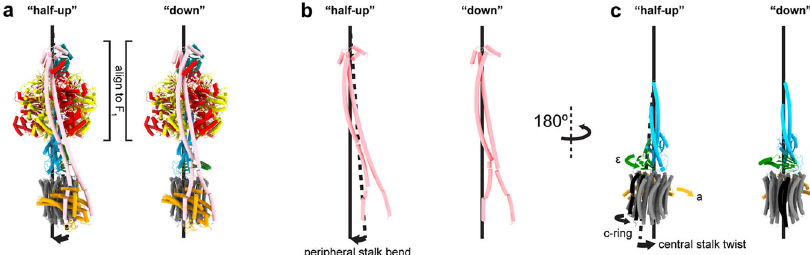
Fig. 5 Movements of the central and peripheral stalks. Side views showing the comparison of State 2 half-up and down sub-states. a Intact F 1 F o complexes shown as tube cartoon. b The peripheral stalk (dimer of b subunits) bends counterclockwise and c the central stalk twists clockwise, facilitating a rotation of two c subunits in the F o